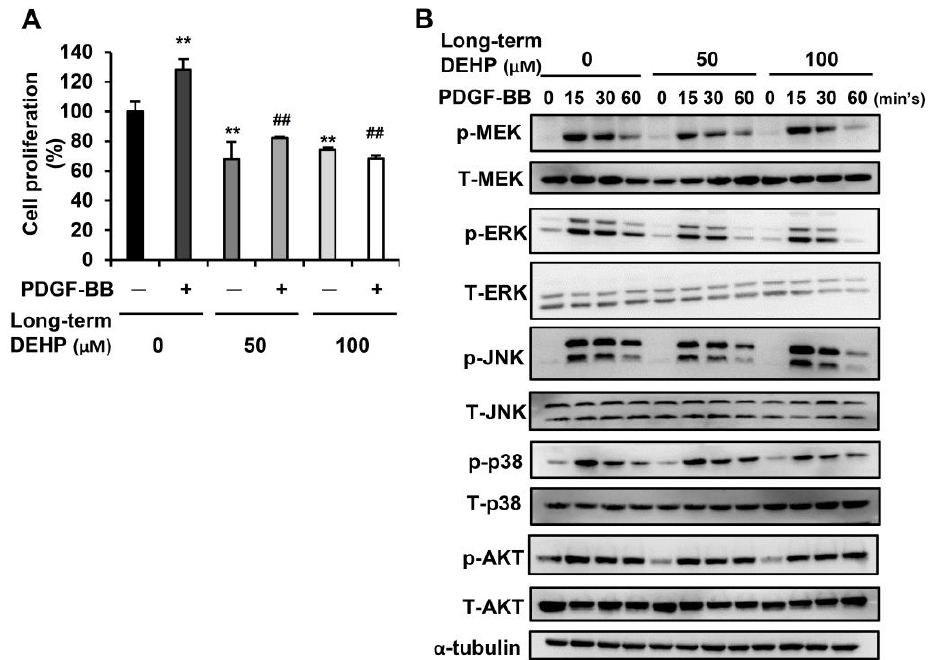
Figure 4. Effects of long-term, low-dose DEHP exposure on PDGF-BB induced proliferation in HSC-T6 cells. (A) Long-term, low-dose, DEHP-exposed HSC-T6 cells were treated with 10 ng/mL PDGF-BB for 48 h, and the cell proliferation was analyzed by MTT assay. ** p < 0.01 vs. black bar. ## p < 0.01 vs. PDGF-BB-treated parental HSC-T6 cells. (B) Western blot analysis of total and phosphor-MEK, ERK, JNK, p38, AKT, and α -tubulin in PDGF-BB-treated long-term, low-dose, DEHP-exposed HSC-T6 cells.